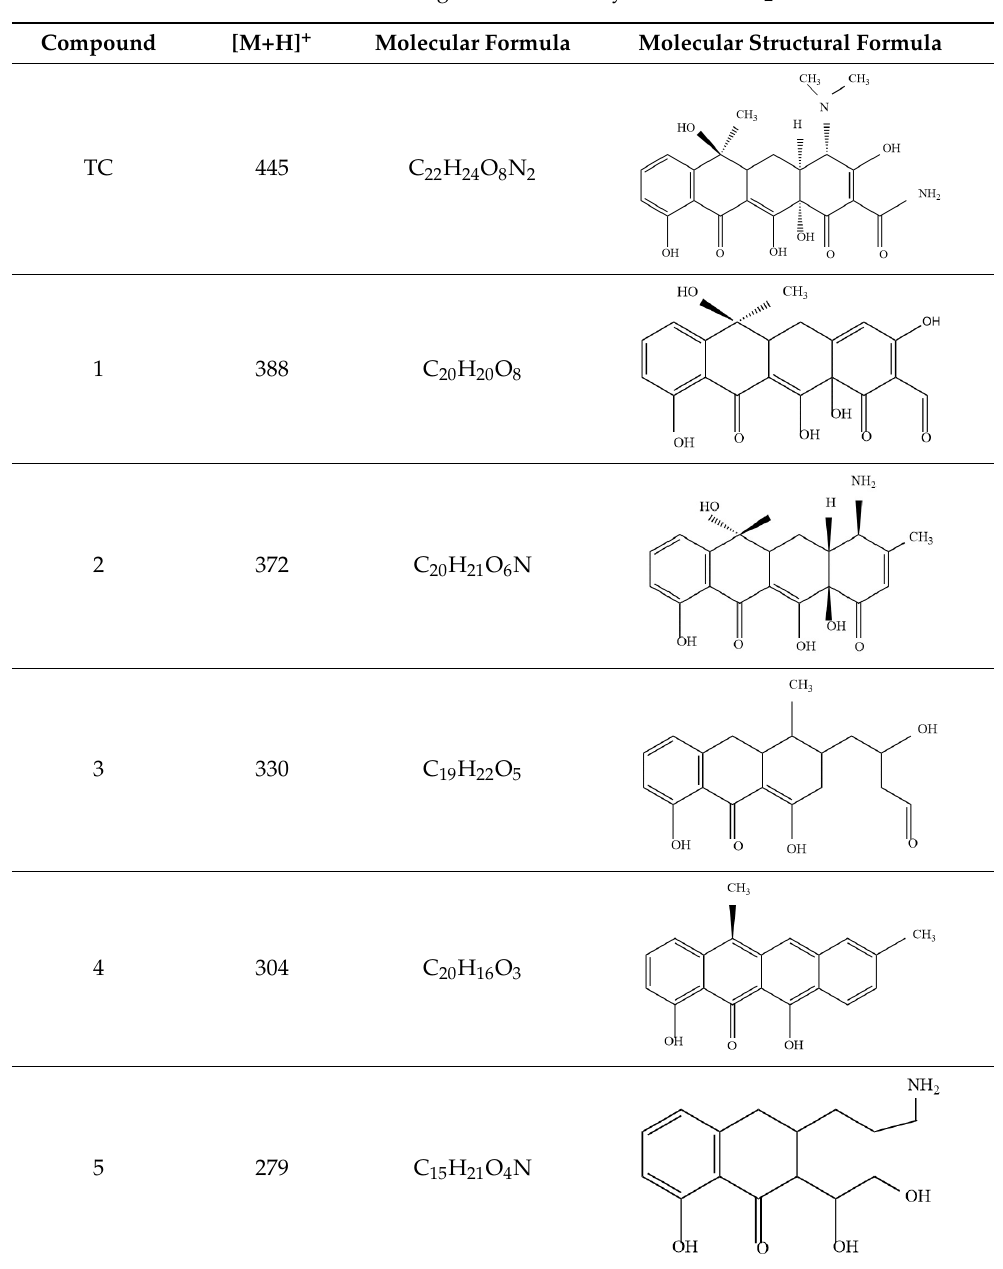
Table 2. Intermediate determined in the degradation of TC by ZnO-C/MnO 2 .